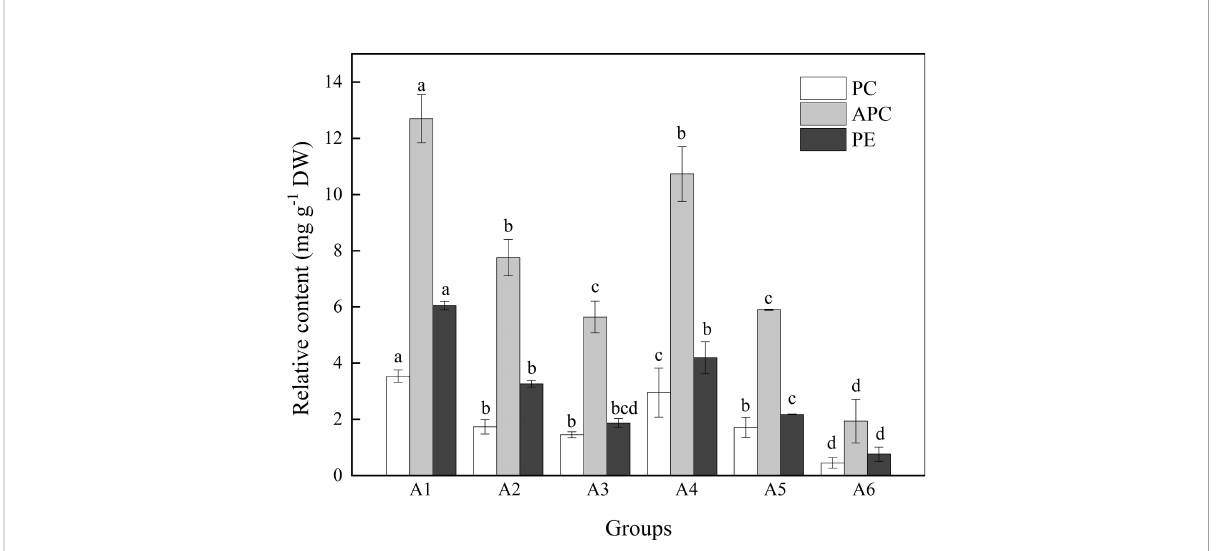
FIGURE 3 The contents (%) of PC, APC, and PE when A. cf. fragilissima was exposed to different conditions over 4 weeks (A1: 60 m mol photons m − 2 s − 1 , 26°C; A2: 80 m mol photons m − 2 s − 1 , 26°C; A3: 120 m mol photons m − 2 s − 1 , 26°C; A4: 60 m mol photons m − 2 s − 1 , 32°C; A5: 80 m mol photons m − 2 s − 1 , 32°C; and A6: 120 m mol photons m − 2 s − 1 , 32°C). Error bars correspond to the standard deviation with three independent replicates. abcd , Different letters implied signi fi cant differences ( P < 0.05) for each parameter.